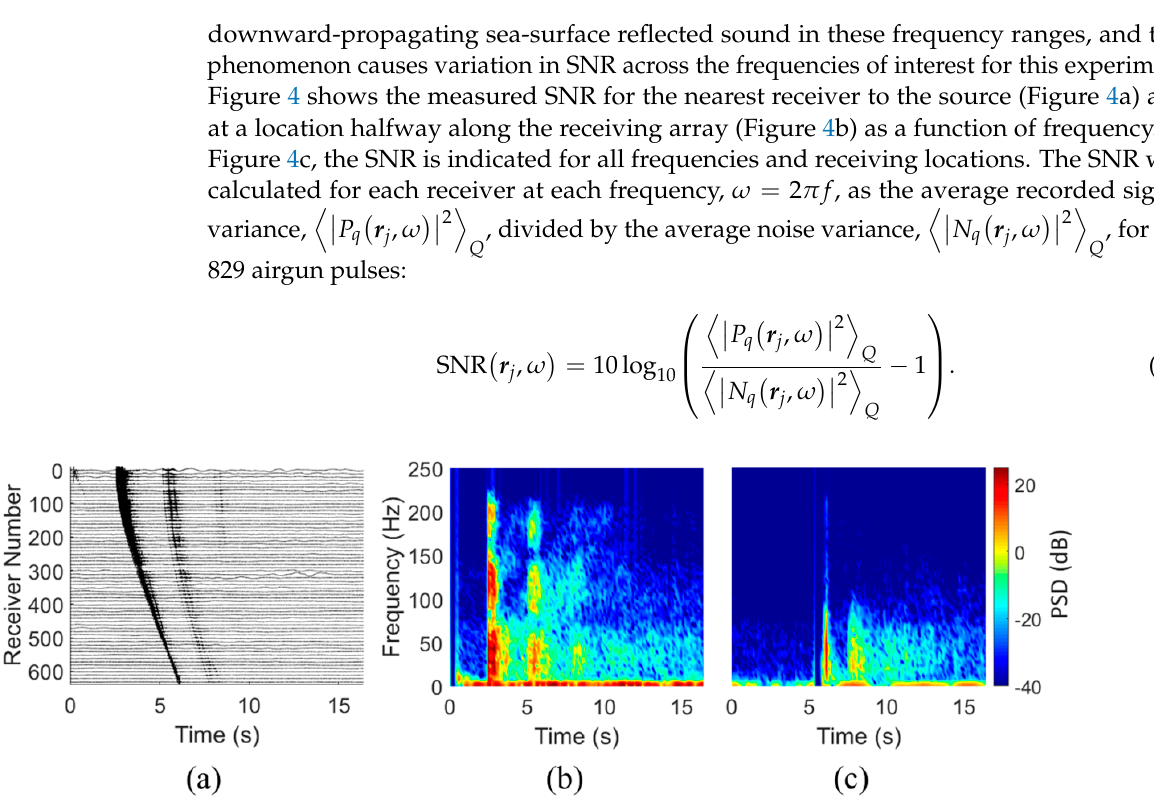
Figure 3. ( a ) Waterfall plot showing the time-series output of every 10th receiver for the ping recorded at 06:36:16 GMT on 22 July 2012. Spectrogram outputs with time-gated direct path, 256 ms Hamming window and 128 ms window overlap for the receivers closest to ( b ) and furthest from ( c ) the source.